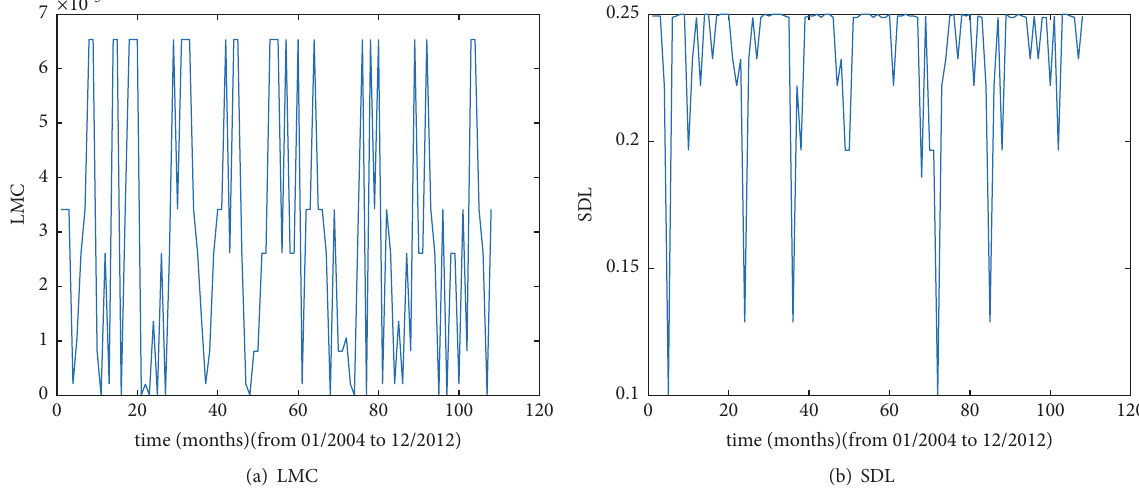
Figure 2: Temporal evolution of complexity (8-part division).